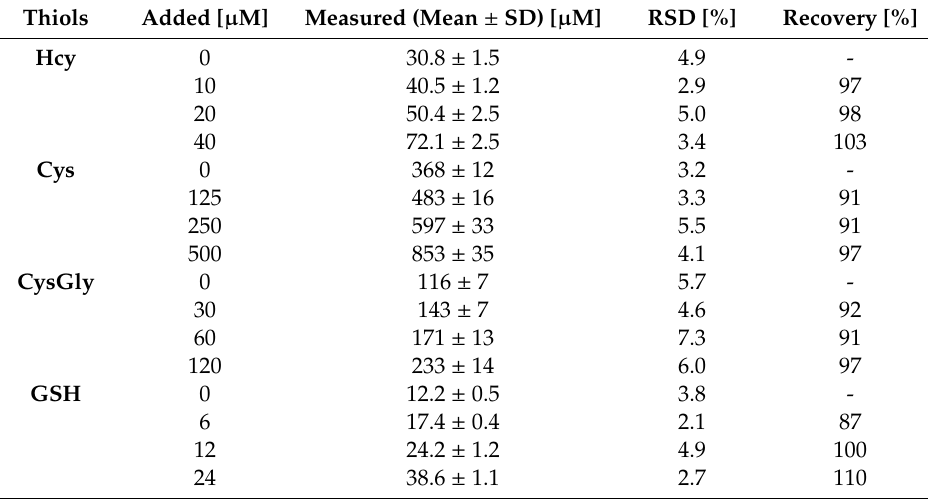
Table 3. Inter-day precision and recovery of thiols in mouse urine samples ( n = 5).